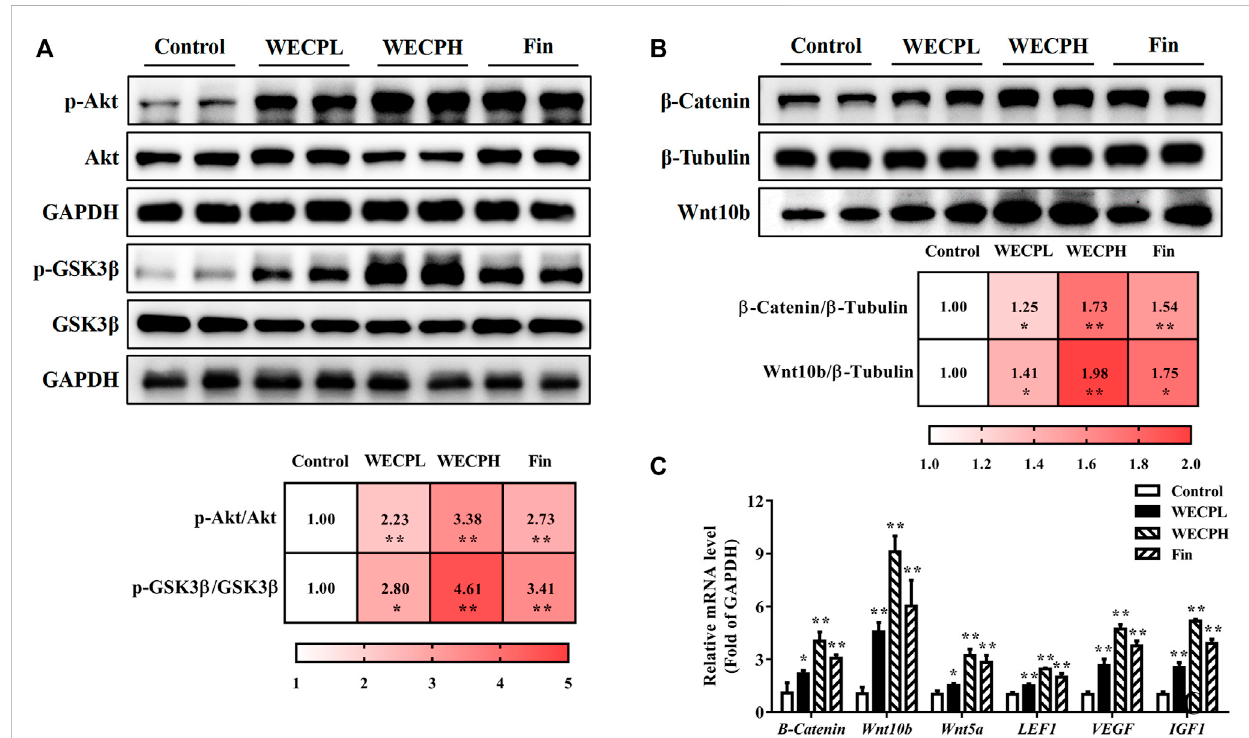
FIGURE 5 WECP activated Akt/GSK3 β / β -Catenin signaling pathway in denuded mouse skin. (A) Effects of WECP and fi nasteride treatments on Akt and GSK3 β proteinphosphorylationinmouseskin. (B) EffectsofWECPand fi nasteridetreatmentson β -CateninandWnt10translationalexpressioninmouseskin. (C) Effects of WECP and fi nasteride treatments on transcriptional expression of β -Catenin, Wnt10b, Wnt5a, LEF1, VEGF, and IGF1 in mouse skin. Data are means ± SD of three independent replicates. * p < 0.05, ** p < 0.01, *** p < 0.001 vs. control group. WECPL, WECPH, and Fin represent low-dose WECP, high-dose WECP, and fi nasteride treatment,